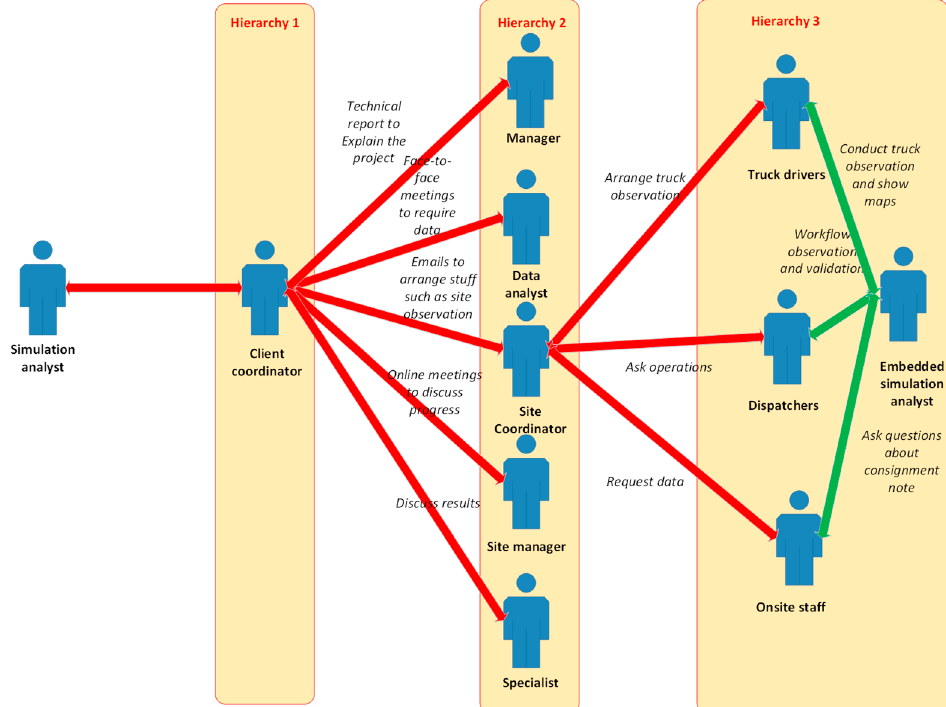
Figure 7. Communication flow for MVM development includes provision for the simulation analyst to interact both with a client coordinator and in an embedded role. Red arrows indicate the conventional knowledge-acquisition process, and green arrows indicate the embedded knowledge-acquisition process.